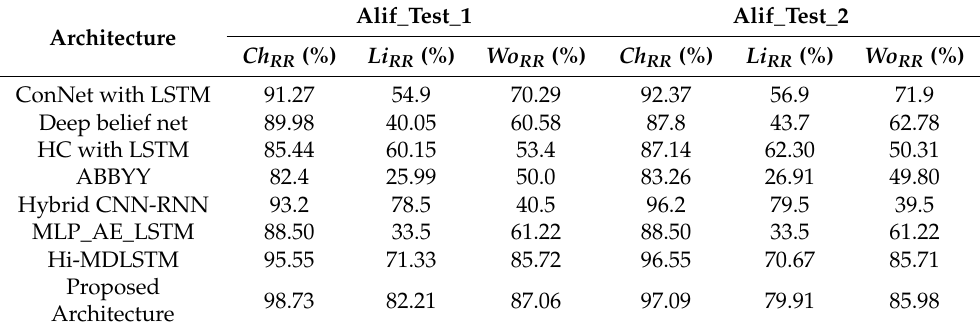
Table 4. Results on Alif dataset and comparison with other architectures.